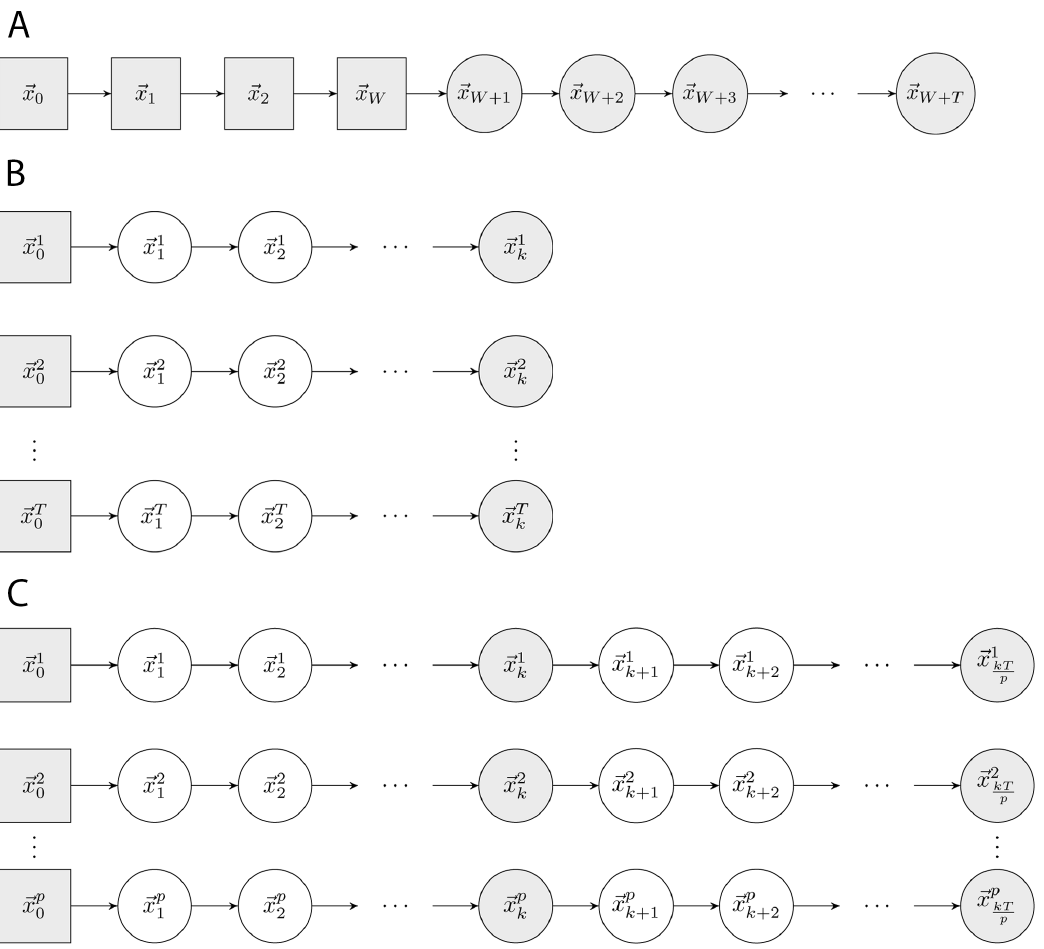
Figure 2. Conceptual difference between the samplers. Conceptual difference between (a) ACHR, (b) gpSampler and (c) optGpSampler. Warm- up points are depicted as gray rectangles, samples that are stored as gray circles. Uncoloured circles denote points that are visited by the sampler, but are not stored as a sample. a) The original ACHR algorithm starts at a point ~ xx 0 and iteratively moves to a next point ~ xx i = ~ xx i { 1 z l i ~ uu i . One chain is used, with step count k =1. The chain contains W warm-up points and T samples. b) GpSampler uses the linear programming procedure described in the main text to find T warm-up points. Then, each of the warm-up points is iteratively moved in the space in the same fashion as the ACHR algorithm in (a), leading to T sampling chains. Each chain of length k returns its end point as a sample. c) OptGpSampler obtains 2 n warm-up points. For each of the p processors used, a warm-up point is chosen randomly as the initial point ~ xx 0 j , with j [ f 1,2, ... , p g . Starting from the warm-up points, new points are found in the same fashion as for the ACHR algorithm in (a), but now only every k th point is kept as a sample. Again, the result is T sample points, but now these have travelled k up to kT = p steps from a warm-up point. Compared to gpSampler , it uses less but much longer sampling